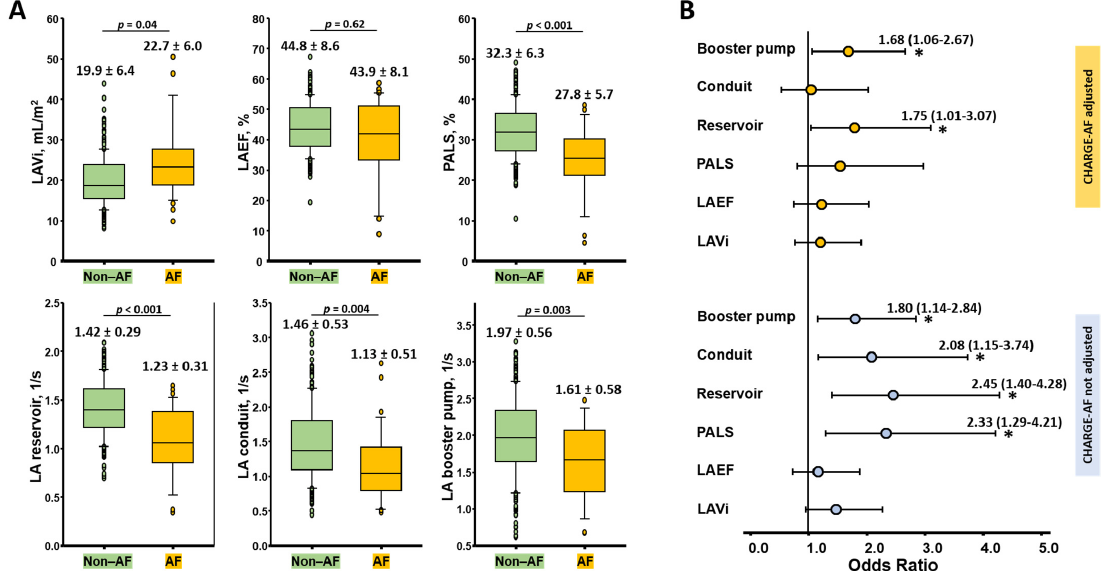
Figure 4. ( A ) Comparisons of various LA mechanical parameters between subjects with AF (n = 25) and those without AF (n = 224). ( B ) Odds ratios for the different LA mechanical parameters that were used for identifying AF. The baseline model for each LA parameter as a predictor was transformed into a standardized z-score and was separately examined. All parameters were subjected to a uniform adjustment for daily drinking dose and presence of ALDH2 polymorphism (binary variable) (lower panel). Multivariate models were further subjected to adjustment for CHARGE-AF scores (upper panel). PR (OR: 1.10, 95% CI: 0.72–1.69, p = 0.65), LAVi (OR: 1.47, 95% CI: 0.95–2.27, p = 0.086), and LAEF (OR: 1.16, 95% CI: 0.72–1.88, p = 0.54) were non-significant predictors prior to the adjustment for CHARGE-AF. * denotes p < 0.05 in the models.